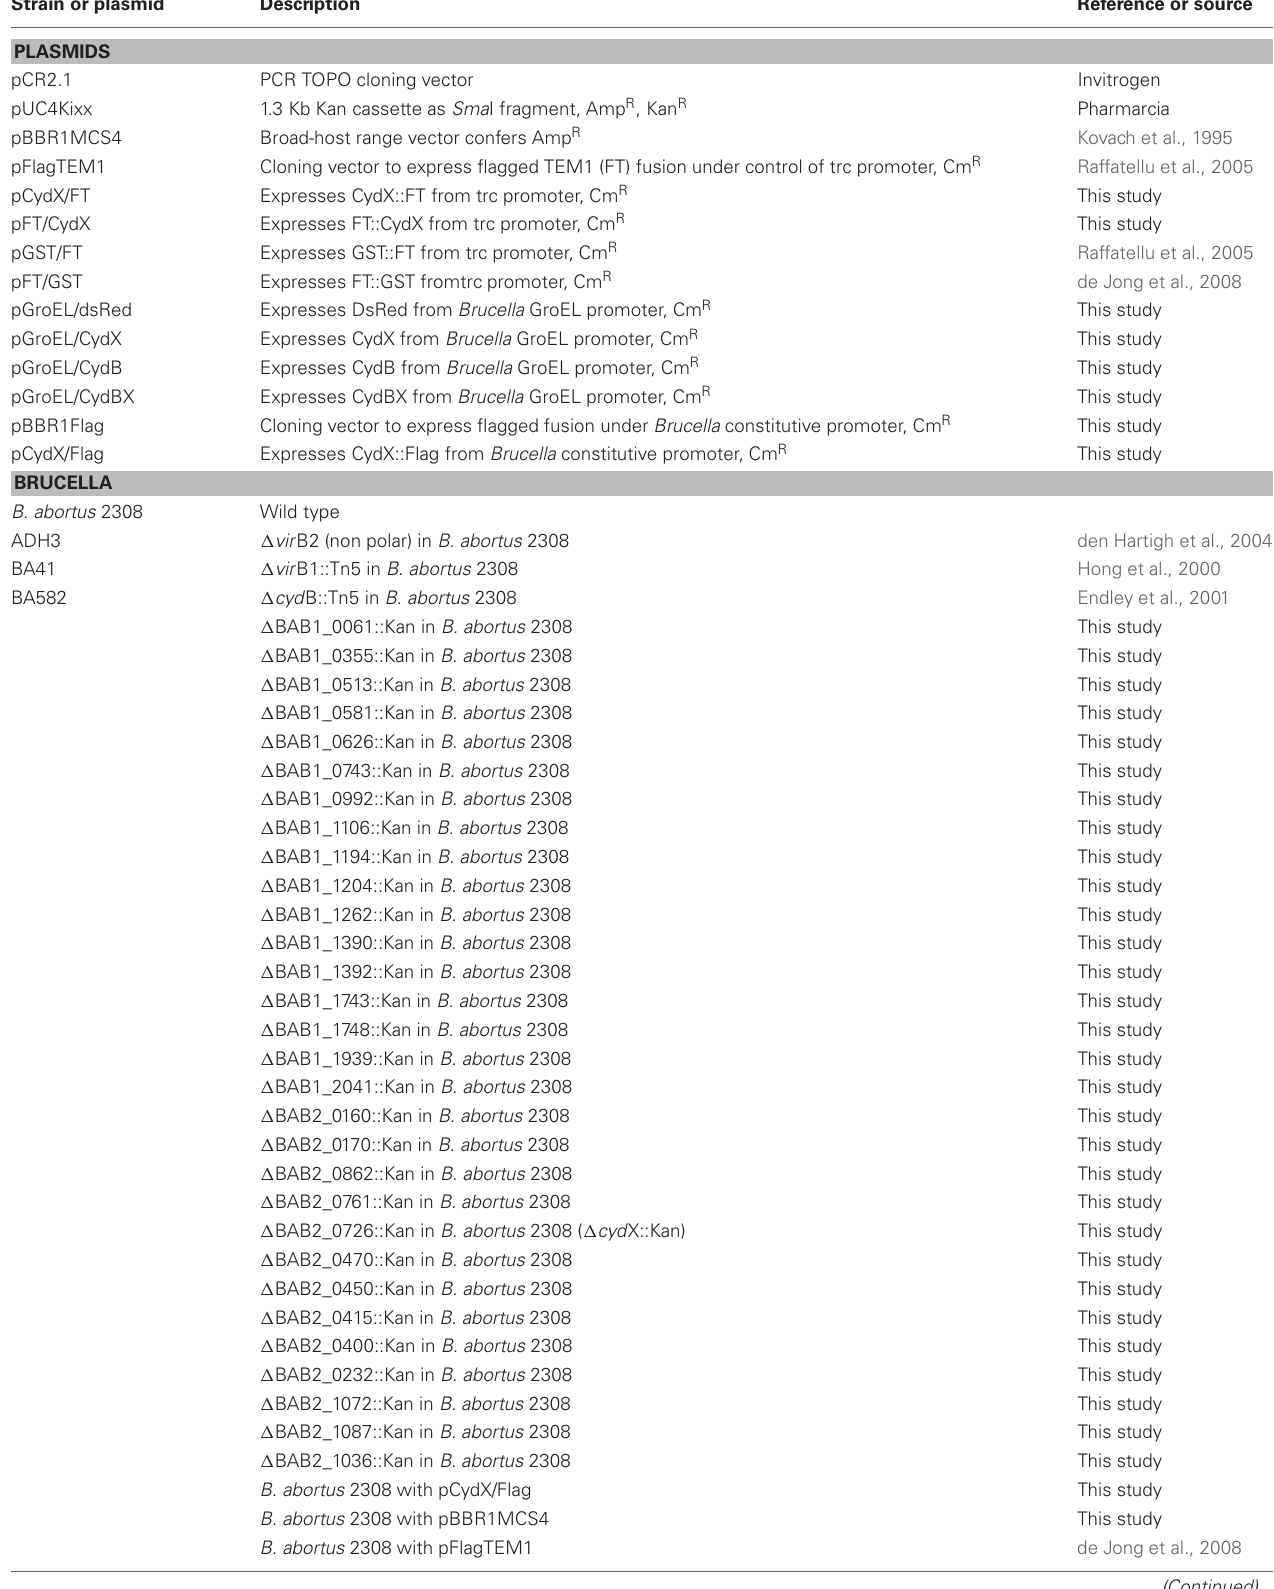
Table 1 | Strains and plasmids used in this work. Strain or